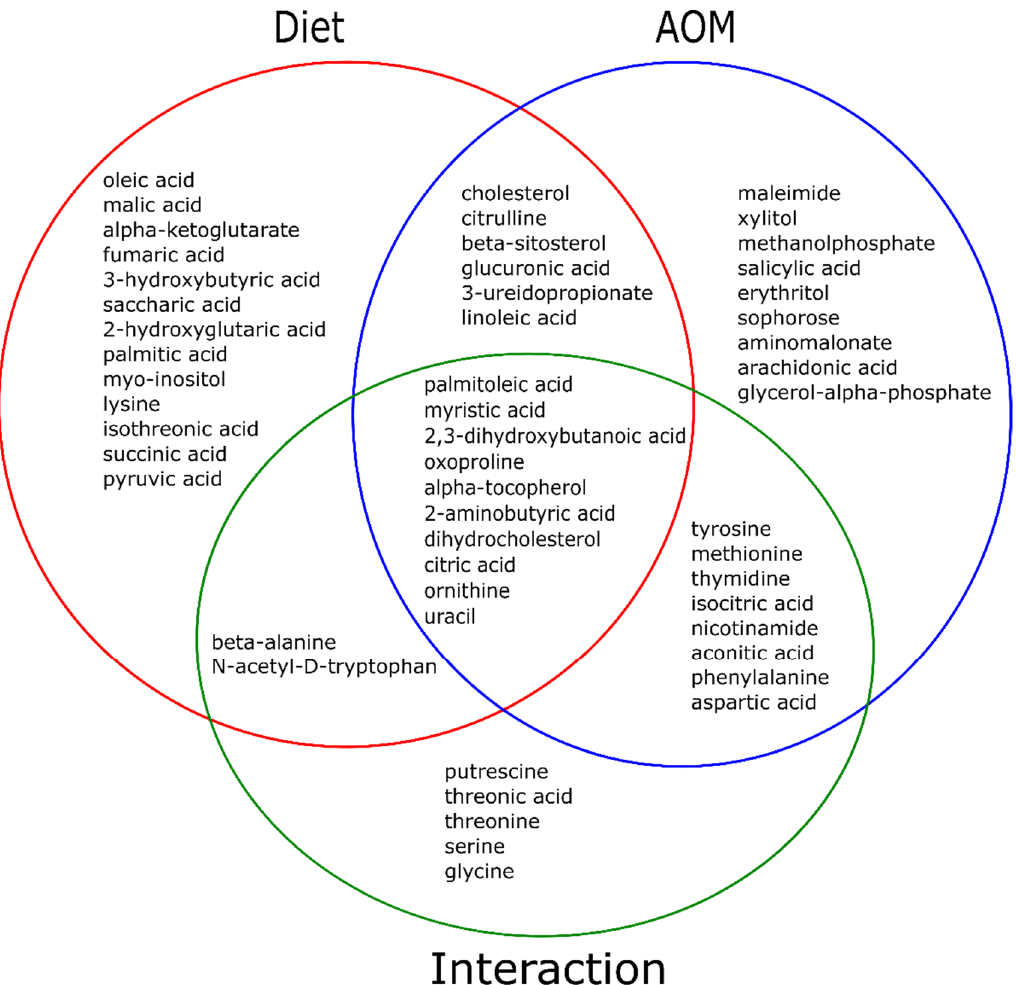
Figure 2. The interaction effect of diet and AOM on 53 plasma metabolites. Plot of significant interacting metabolites (green circle, 25 of 53 metabolites) by diet vs. AOM interaction, and two-way ANOVA between diet (red circle) and AOM (blue circle) with an FDR-adjusted p < 0.05. Mice without AOM treatment (control) n = 10/group (AIN or HFD group). Mice with AOM treatment, n = 15/group (AIN + AOM or HFD + AOM group).